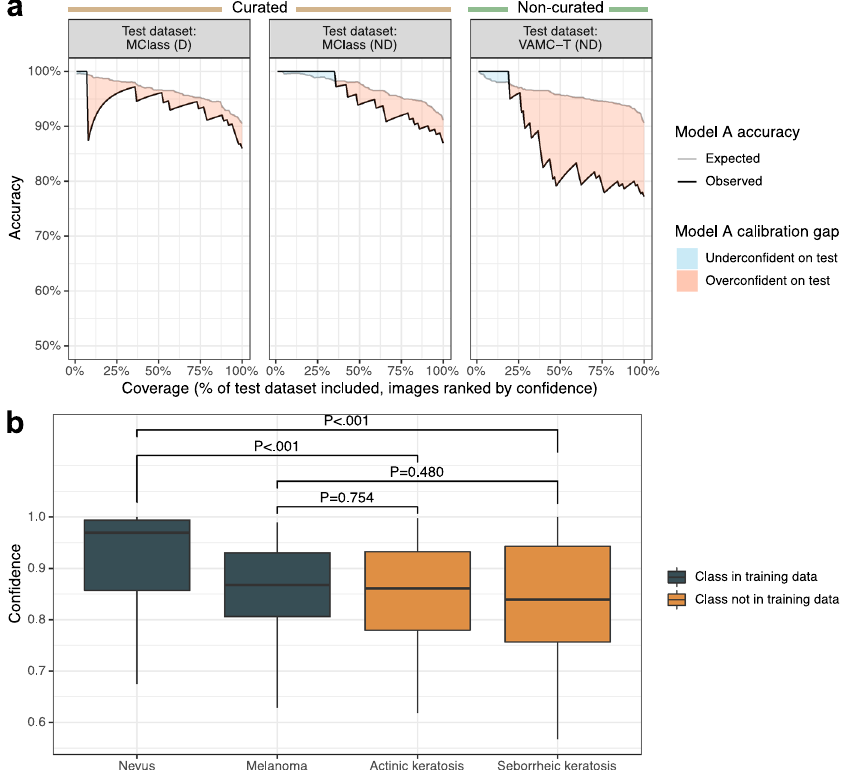
Fig. 2 Calibration on development dataset does not generalize to benchmark test datasets. a Response rate accuracy curves showing expected accuracy (i.e., accuracy on validation dataset, gray line) and observed accuracy (black line) are plotted against coverage, or the percentage of the test dataset evaluated, with test images ranked by descending Model A prediction con fi dence. Different values of coverage were obtained by varying the con fi dence threshold across the range of con fi dences for test dataset predictions, such that only predictions with con fi dence greater than the threshold were considered. Accuracy was calculated using a melanoma probability threshold of 0.5, i.e., the predicted class was the class with higher absolute probability. A sharp dip in accuracy from 100% to 87.5% was observed at 8% coverage for MClass-D ( n = 100) because the prediction ranked 8th out of 100 by con fi dence was incorrect, resulting in accuracy 7/8 = 87.5%. b Model A prediction con fi dence across test images from disease classes encountered during model training (melanoma, nevus) vs those not encountered during training (actinic keratosis, seborrheic keratosis; con fi dences plotted on out-of-distribution images are for a prediction of melanoma). All images are from the ISIC archive. P -values from the Wilcoxon rank sum test are shown in text. There is no statistically signi fi cant difference in con fi dence on images with a true diagnosis of melanoma vs actinic keratosis ( P = 0.754) or seborrheic keratosis ( P = 0.480). Each boxplot displays the median (middle line), the fi rst and third quartiles (lower and upper hinges) and the most extreme values no further than 1.5 * the interquartile range from the hinge (upper and lower whiskers). Abbreviations: D dermoscopic, ISIC International Skin Imaging Collaboration, MClass Melanoma Classi fi cation Benchmark, ND non-dermoscopic, VAMC-T Veterans Affairs Medical Center